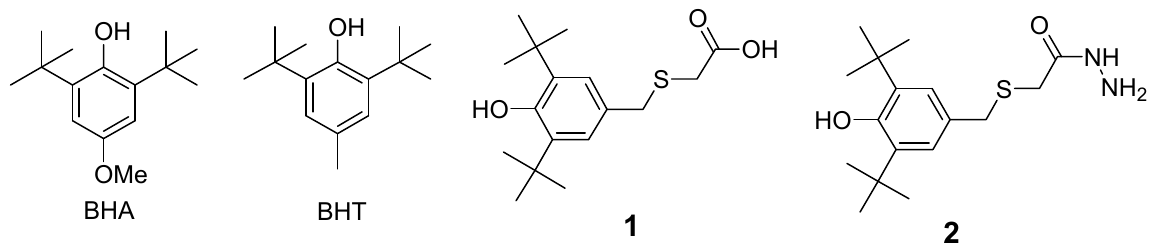
Figure 1. Chemical structures of compounds BHA, BHT, 1 and 2 .